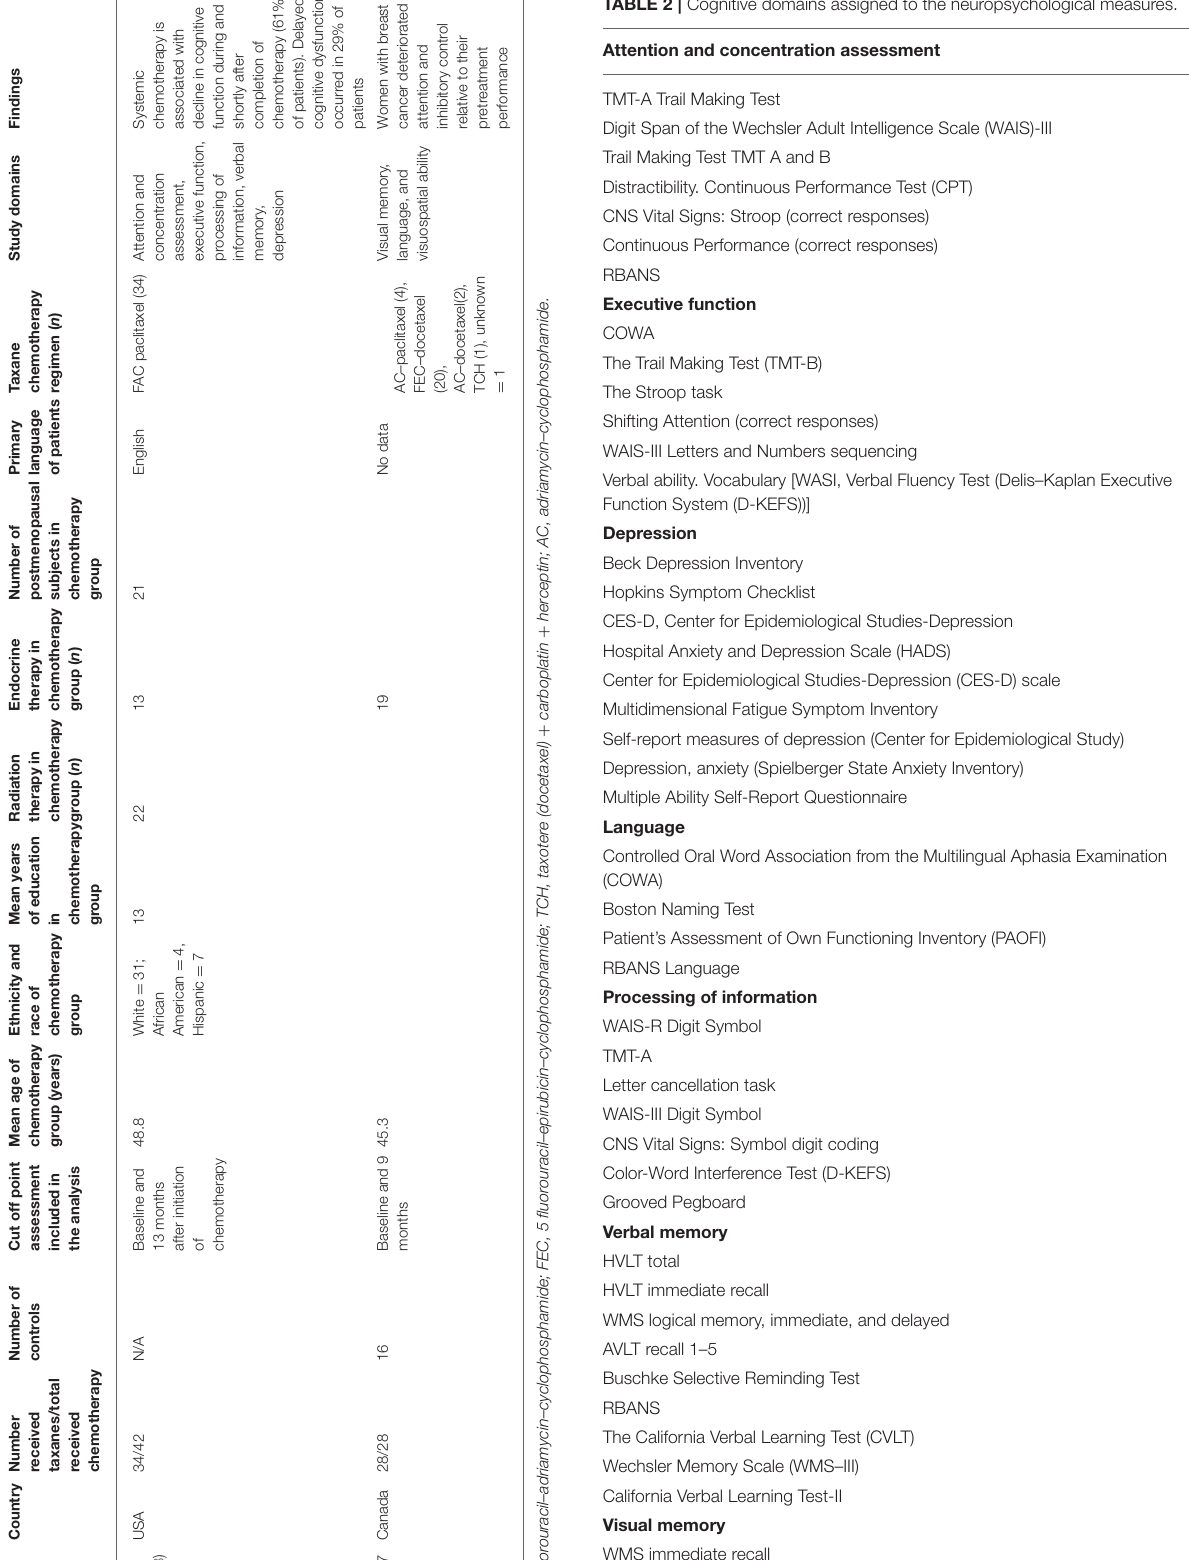
TABLE 2 | Cognitive domains assigned to the neuropsychological